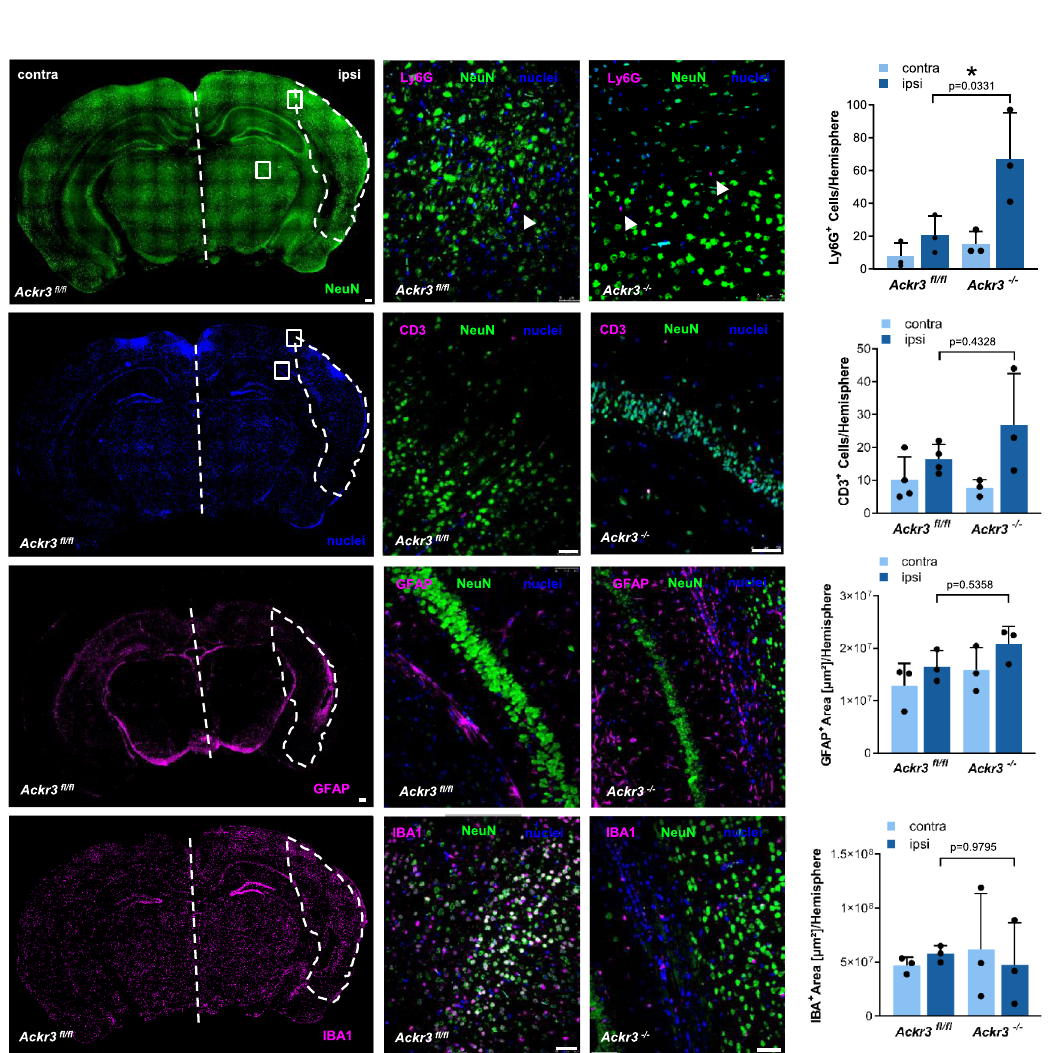
Fig. 8 De fi ciency in platelet ACKR3 results in altered cell migration into the brain following ischemia/reperfusion. Immunostaining and statistical analysis of tMCAO brain sections. Ly6G + staining, n = 3; CD3 + staining, Ackr3 fl / fl : n = 4, Ackr3 − / − : n = 3; GFPA + staining representing activated astrocytes, n = 3; IBA + staining, n = 3. Plotted: mean ± S.D.; statistics: one-way ANOVA, 95% con fi dence degranulation of α -granules (P-selectin), platelet-mediated veri fi ed in experiments with Ackr3 − / − platelets. In contrast to thrombus formation ex vivo and in vivo was signi fi cantly atte- wild-type platelets, the presence of ACKR3-agonists did not nuated suggesting that platelet ACKR3 acts as an inhibitory decrease activation-induced degranulation or thrombus forma- surface receptor. The speci fi city of the ACKR3-agonists was tion under fl ow. Next, we tested whether systemic administration